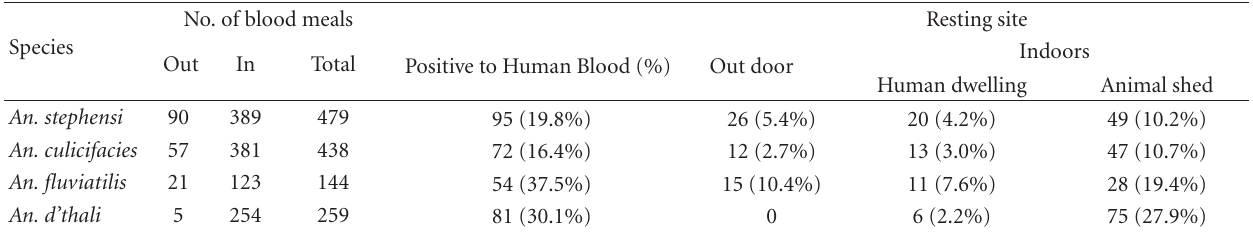
Table 1: Analysis of anthropophilic index of anopheline vectors according to type of resting places in south and southeastern Iran (the malaria endemic area) during study